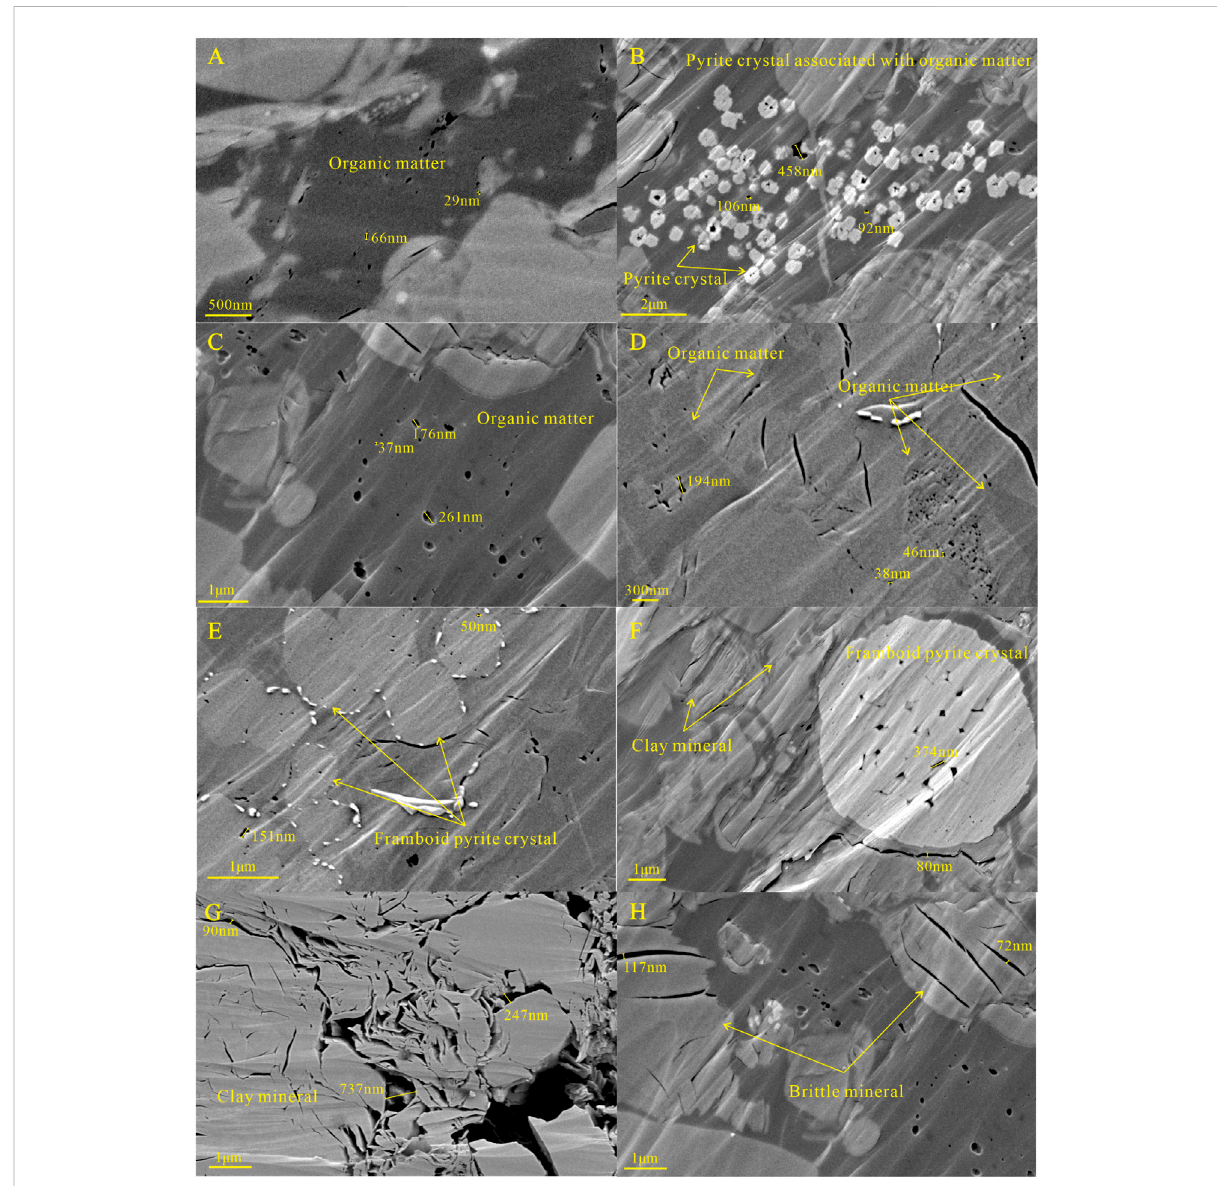
FIGURE 2 Argon ion polishing FE-SEM photographs of Longtan shales (Zhang et al., 2018; Huang et al., 2020). (A) . 751.04 m, silty mudstone, ellipsoidal organic pores developed, mainly mini-mesopores; (B) . 781.42 m, carbonaceous shale, pyrite crystal associated with organic matter, microfractures developing around granules; (C) . 781.42 m, carbonaceous shale, spherical organic pores developed, mostly meso-macropores; (D) . 779.27 m, carbonaceous shale, honeycomb, and quasi-honeycomb organic pores developed, mostly mini-micropores; (E) . 779.27 m, carbonaceous shale, intercrystalline pyrite pores developed inside the framboid pyrite crystal, from minipore to macropores can be observed, microfractures developed at the edge of granules; (F) . 781.42 m, carbonaceous shale, intercrystalline pyrite pores developed inside the framboid pyrite crystal, microfracturescanbeobserved; (G) .709.34 m,carbonaceous shale,claymineralsarestratiformand fl akyshaped,intercrystallineclaymineralpores developed; (H) . 781.42 m, carbonaceous shale, microfractures developed in brittle mineral